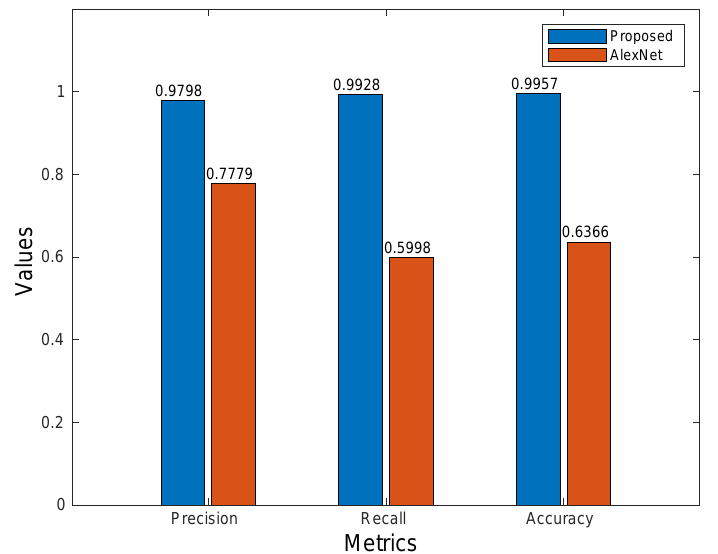
Figure 6. Comparison with AlexNet for PSD category